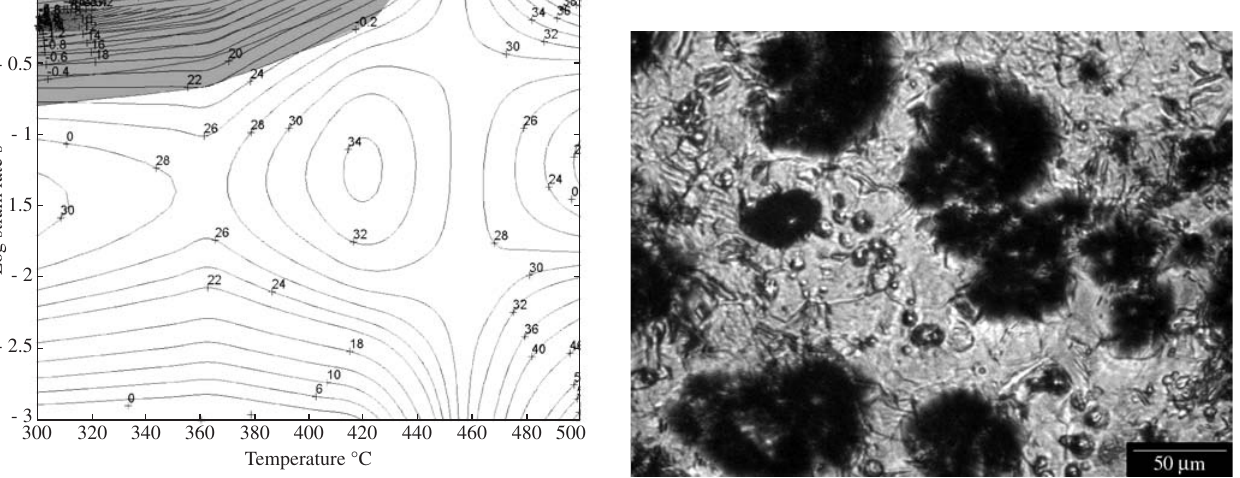
Figure 2. Power efficiency and dissipation map calculated at strain value of e = 0.3: the shaded area represents the zone of unstable flow predicted by Equation 4.